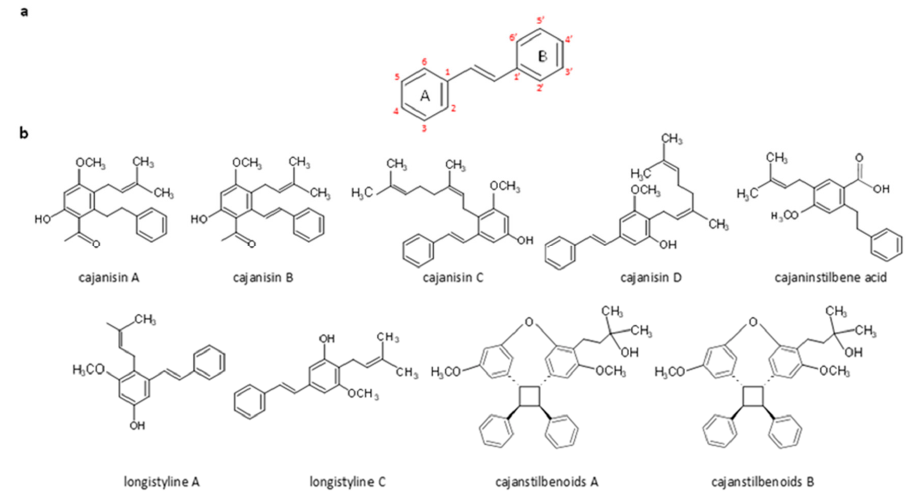
Figure 4. ( a ) Classical C6-C2-C6 chemical backbone and atom numbering of stilbenoids (here trans -stilbenoids are represented). ( b ) Structures of the di ff erent prenylated stilbenoids identified in pigeon pea: cajaninstilbene acid, cajanstilbenoids A-B, cajanusins A-D and longistylin A and